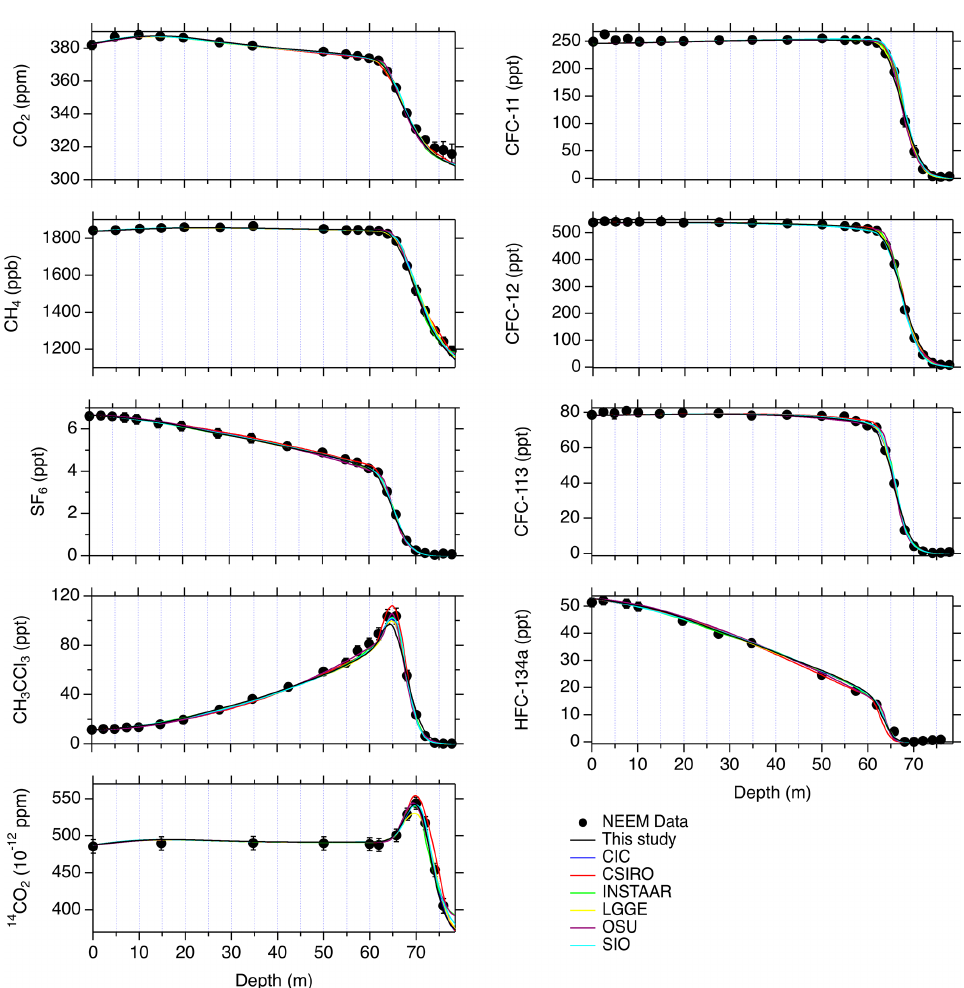
Figure 4. Modelled depth profiles of various compounds in the NEEM firn. Closed circles in black are the observed data with uncertainty estimated by Buizert et al. (2012). Our model results are shown with black solid lines, and the results from other models are in colours. Different models are labelled by institution, according to Buizert et al. (2012), as follows: CIC (Centre for Ice and Climate), CSIRO